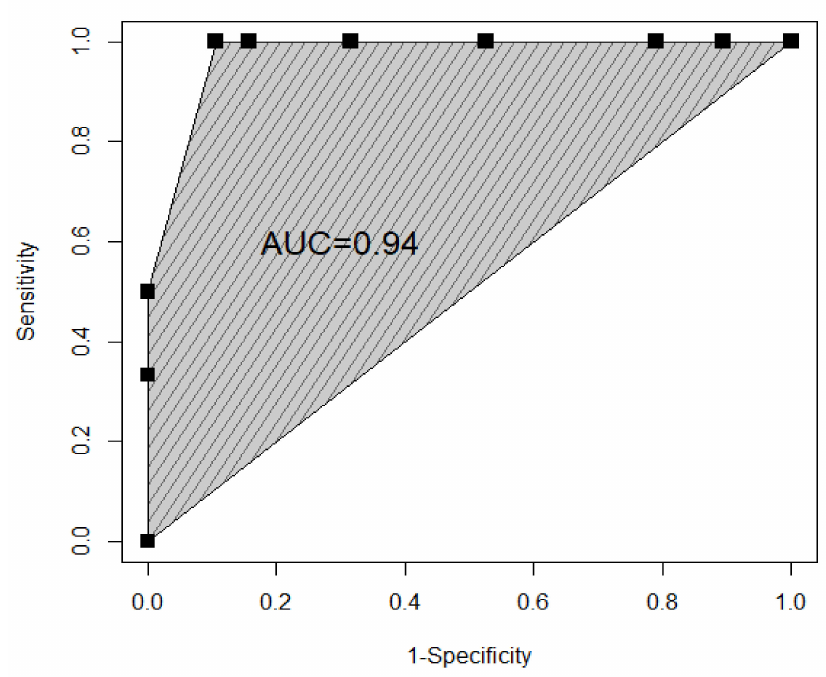
Figure 2. ROC curve for the classification of classes PAS group 1 and PAS group